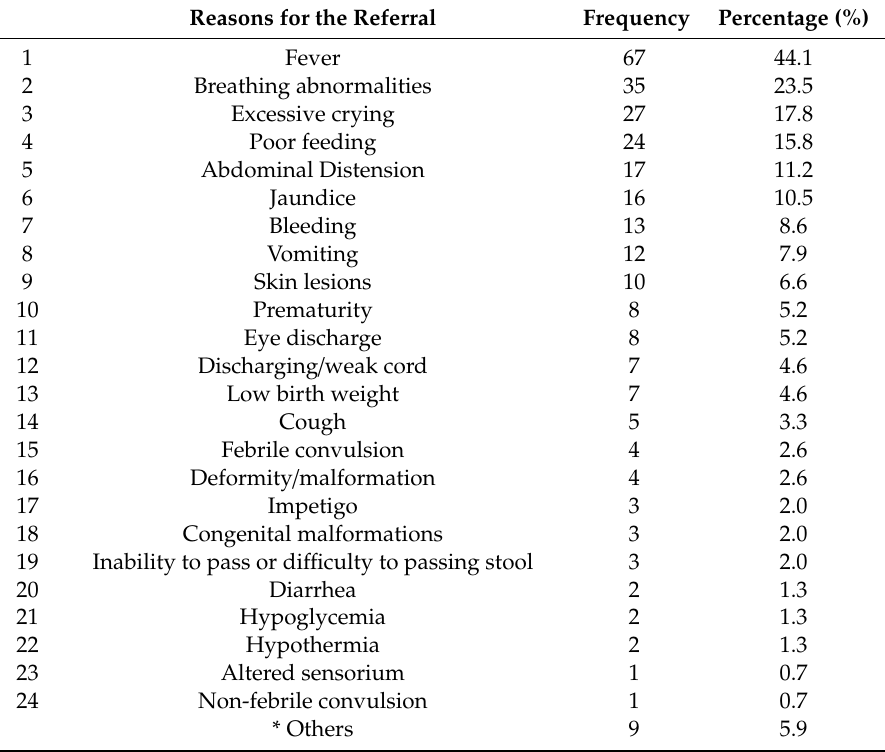
Table 2. Reasons for the referral to Upper West Regional Hospital (UWRH) and St. Joseph’s Hospital (SJH) (multiple answers